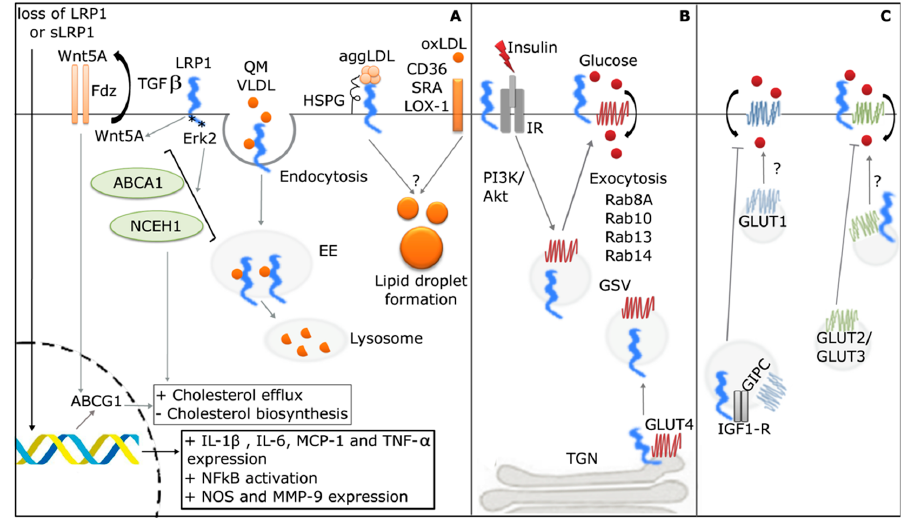
Figure 1. LRP1 role in the lipid metabolisms, glucose homeostasis and inflammation. ( A ) The loss of LRP1 or sLRP1 production can induce pro-inflammatory factors synthesis in macrophages. LRP1 can also regulate the lipid metabolism by endocytosis of cholesterol and triglyceride-rich lipoproteins, such as chylomicrons (QM), very low-density lipoprotein (VLDL) (represented as orange circles) and aggregated low-density lipoprotein (aggLDL) (pink circles) in hepatocytes, vascular smooth muscle cell (VSMCs) and macrophage, and by signaling activation limiting cholesterol intracellular accumulation in fibroblasts; oxidized LDL (oxLDL) is recognized by scavenger receptors (CD36; SRA; and LOX-1) ( B ) LRP1 is essential for the signaling activity of the insulin receptor (IR) in brain and liver, and also in the formation and function of GSVs (GLUT4 storage vesicles) in adipocytes and muscle cells; ( C ) In astrocytes, LRP1 can mediate the GLUT1 trafficking. In neurons and hepatocytes, LRP1 is necessary for GLUT2 and GLUT3 translocation to the plasma membrane. HSPG: Heparan sulfate proteoglycan. SRA: scavenger receptor A. EE: early endosome. NOS: nitric oxide synthase. TGN: trans -Golgi network. *: NP-Xy motif. ?: non-characterized mechanism(s).